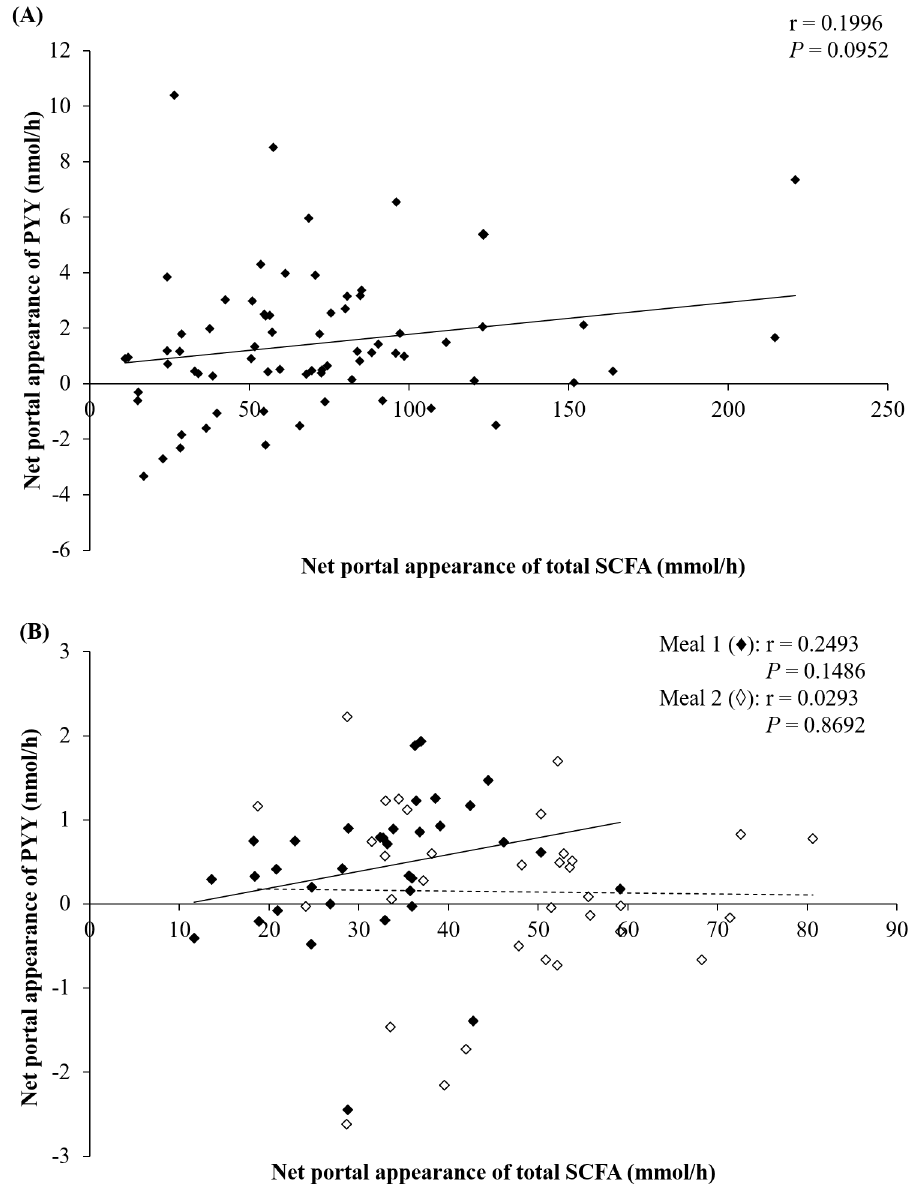
Fig 3. Correlations between net portal appearanceof PYY and NPA of total SCFA in pigs fed WSD, AXD, and RSD. (A) Correlationbetweennet portal appearance of PYY and SCFA for each pig after consumption of WSD, AXD, or RSD, n = 6. Each point representsa correlationbetweennet portal appearance of PYY and SCFA for a given pig on a specific diet (time points 0, 60, 180, and 300 min relativeto first daily meal). (B) Correlationwith first ( ♦ ) and second ( ^ ) meals after consumption of WWG, WAF, or RAF, n = 6. Each point represents the averagenet portal appearanceof PYY (pools1–4 as describedin the Materials and Methods) correlatedto the net portal appearanceof SCFA (pools 1–4) for each pig on each experimental diet. Inserts show the Pearson’sr correlationand the corresponding P -value. Solid line representmeans for meal 1, and the dashedline represent means for meal